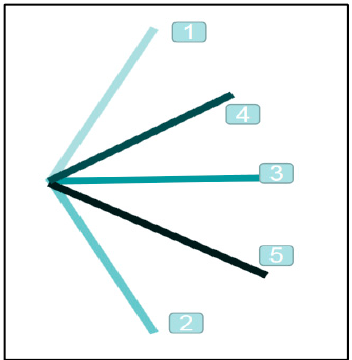
C Figure 4. Five poses generated by C K group. The numbers in the figure indicate the order of Figure 4. Five poses generated by K group. The numbers in the figure indicate the order of pose pose generation.